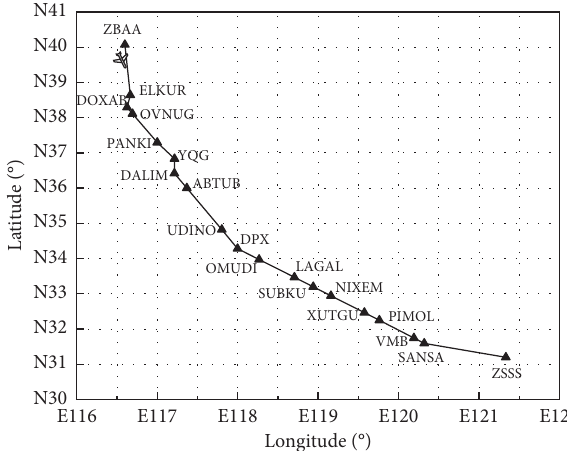
Figure 2: Location of the key points on route ZBAA-ZSSS. Table 2: Aircraft performance parameters of different types of aircraft according to BADA. Parameter